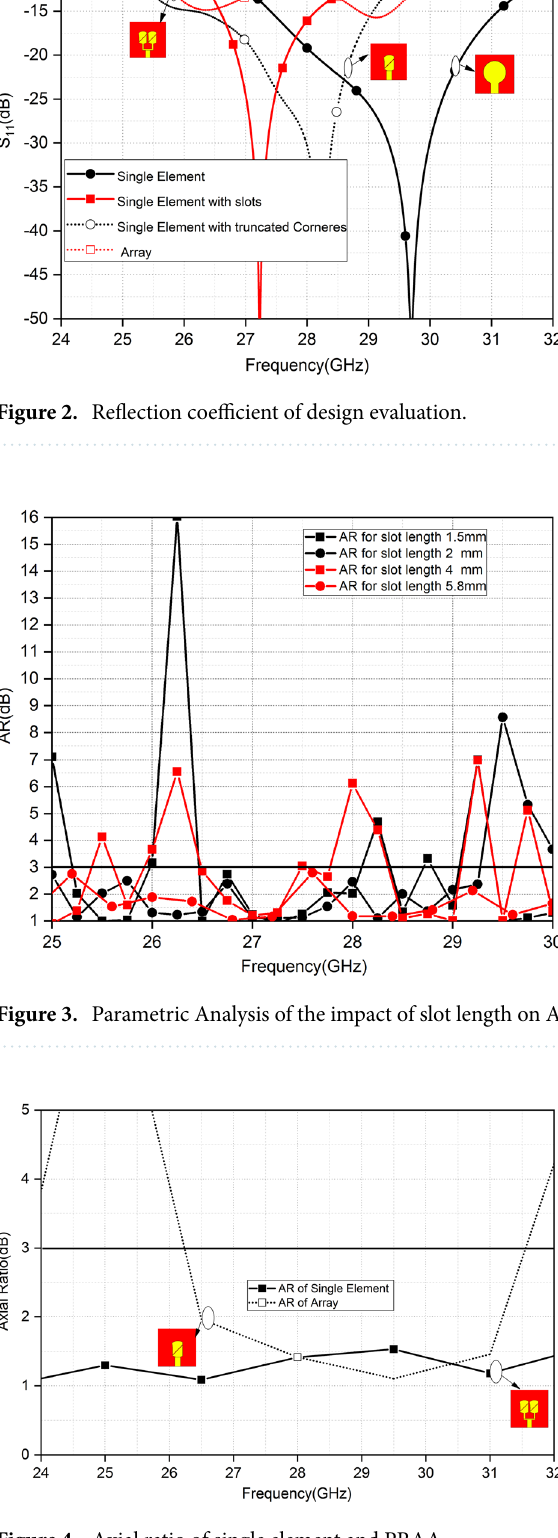
Figure 4. Axial ratio of single element and